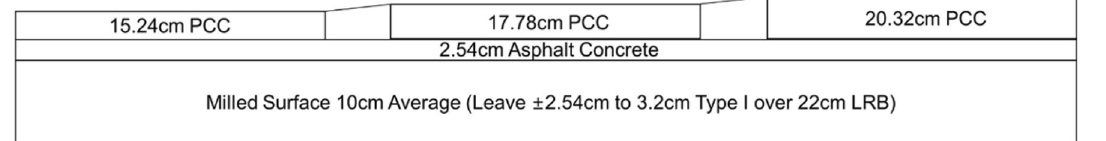
Fig. 4 Pavement structures used for project sections.